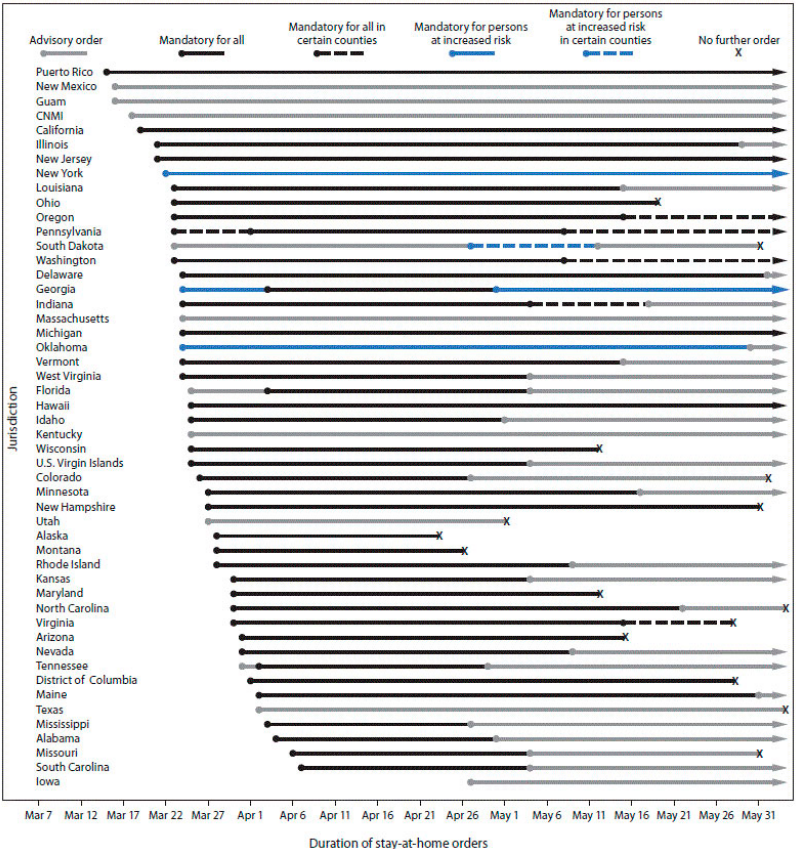
Figure A1. Duration of stay-at-home orders. Source: [14]. “Type and duration of COVID-19 state and Abbreviations: COVID-19 = coronavirus disease 2019; CNMI = Northern Mariana Islands. Including the type of stay-at-home order implemented, to whom it applied, and the period for which it was in place. Jurisdictions that did not issue any orders requiring or recommending persons to stay home during the observation period were not included in this figure. Jurisdictions without any orders were American Samoa, Arkansas, Connecticut, Nebraska, North Dakota, and Wyoming. The figure is a line chart showing COVID-19 state and territorial stay-at-home orders in the United States during